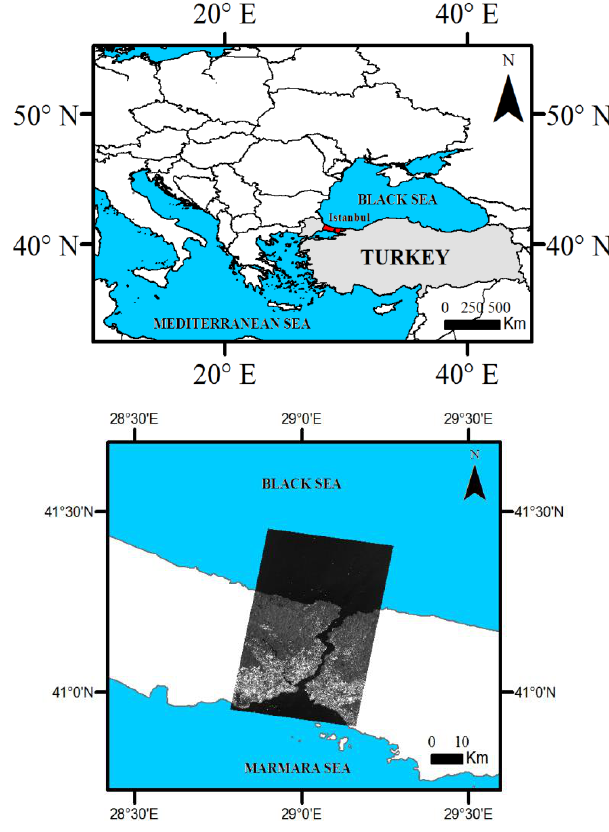
Figure 1. Location of the study area